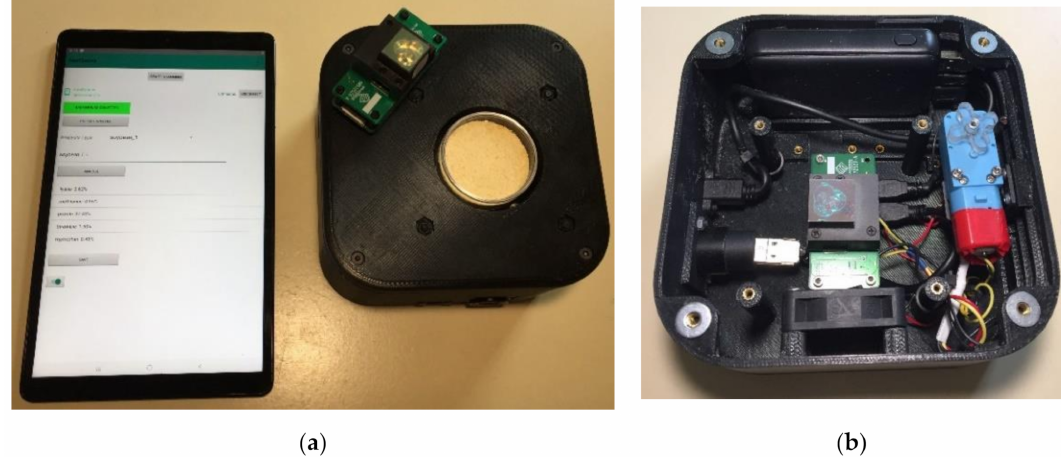
Figure 1. Photograph of the handheld NIR prototype sensor used for soybean samples spectra collection ( a ) and an inner view of the spectrometer housing ( b